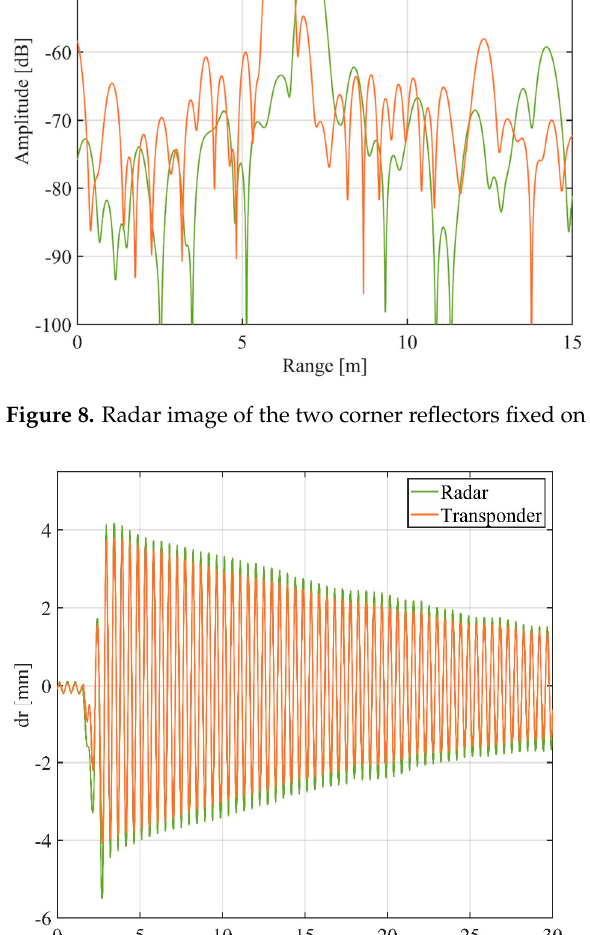
Figure 9. Displacement measured by the radar and the transponder.